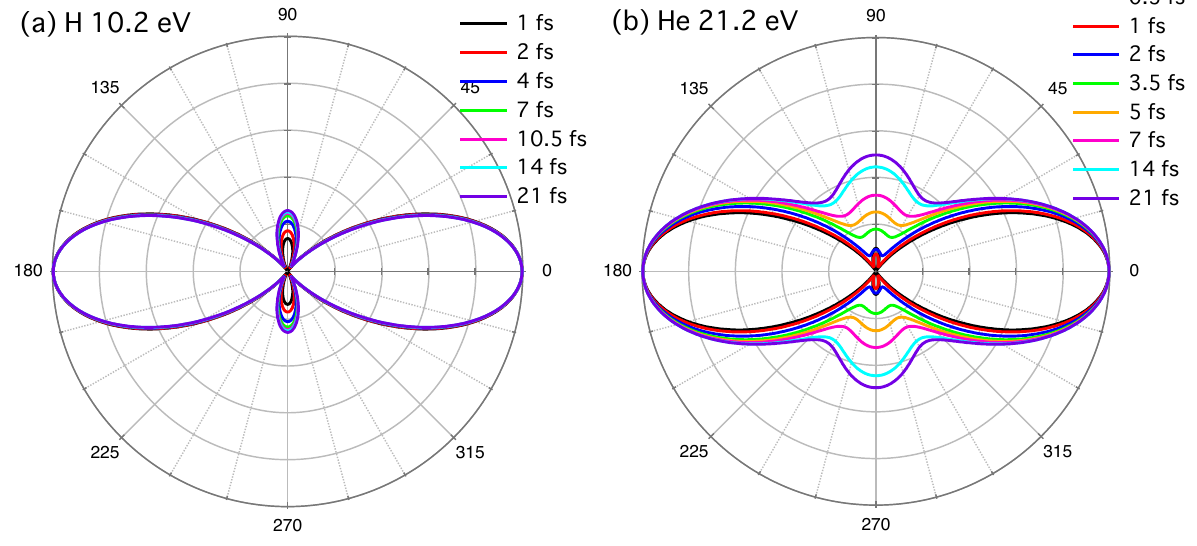
Figure 3. Pulse-width dependence of the photoelectron angular distribution for ( a ) H and (cid:126) ω = 10 . 2 eV ; and ( b ) He and (cid:126) ω = 21 . 2 eV